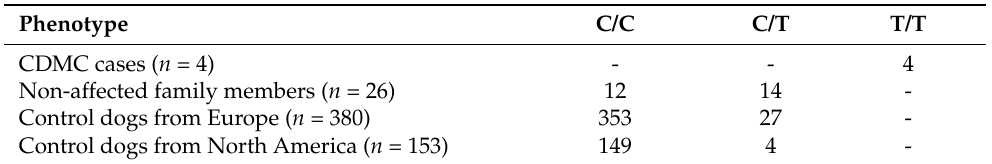
Table 2. Association of the genotypes at SLC25A12 :c.1337C>T variant with cerebellar degeneration— myositis complex (CDMC) in 563 NSDTR